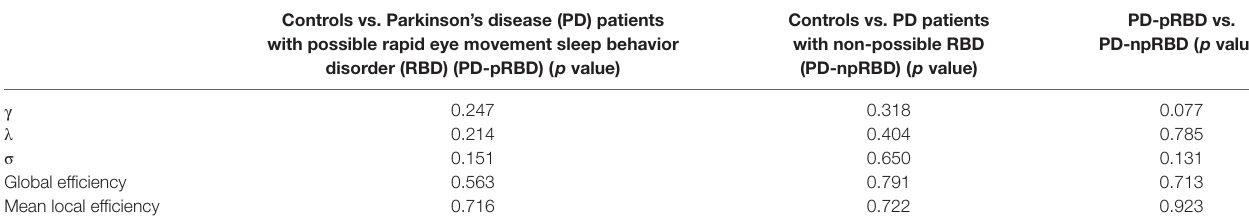
TaBle 2 | Areas under the curve analyses for small-world parameters and global network measures in